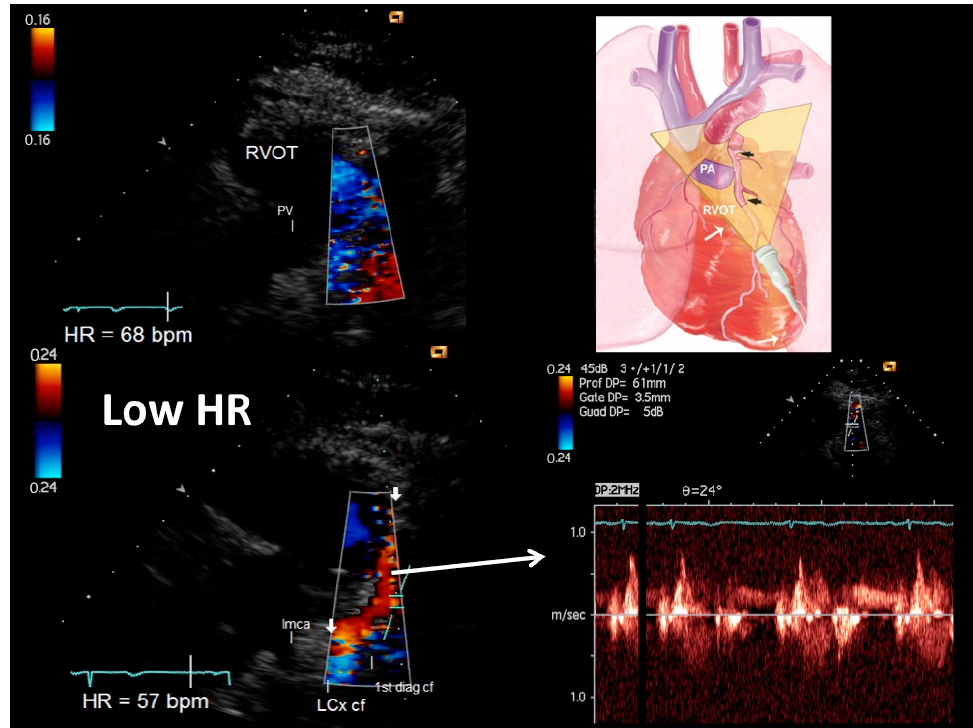
Figure 1. An example of proximal–mid-LAD color flow (plane orientation at the top right corner) at higher HR (68 b/m) (upper right) and after HR reduction (57 b/m) (bottom right): at the baseline with higher HR no flow is detected; after HR lowering (<60 b/m), optimal color signal is recorded in the LAD so allowing color-guided pulsed-wave Doppler sampling of optimal quality (bottom right). Additionally, the first thin diagonal branch is depicted along with the origin of the left circumflex coronary artery whose flows are coded in blue since are away from the probe. The left main coronary artery (directed posteriorly) is evident in B-mode. LMCA = left main coronary artery; LCx cf = proximal left circumflex coronary artery color flow; 1st diagonal cf = first diagonal color flow; LMCA = left main coronary artery; RVOT = right ventricular outflow tract; pv = pulmonary